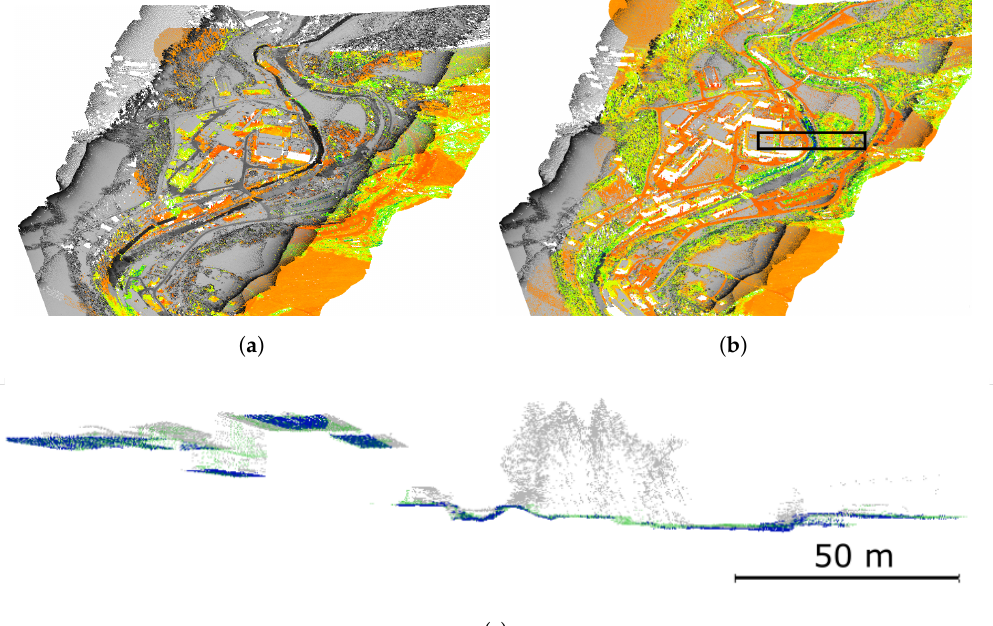
Figure 8. Result of the proposed approach shown on the fifth scene. ( a ) Overview of the fifth scene with initial transformation. ( b ) Overview of the fifth scene with registration result. ( c ) Profile view of the marked area in ( b ). Shown data are the original data of 2012 and the data of 2017 downsampled to 0.5 m GSD. The color representation is the same as in Figure 3.